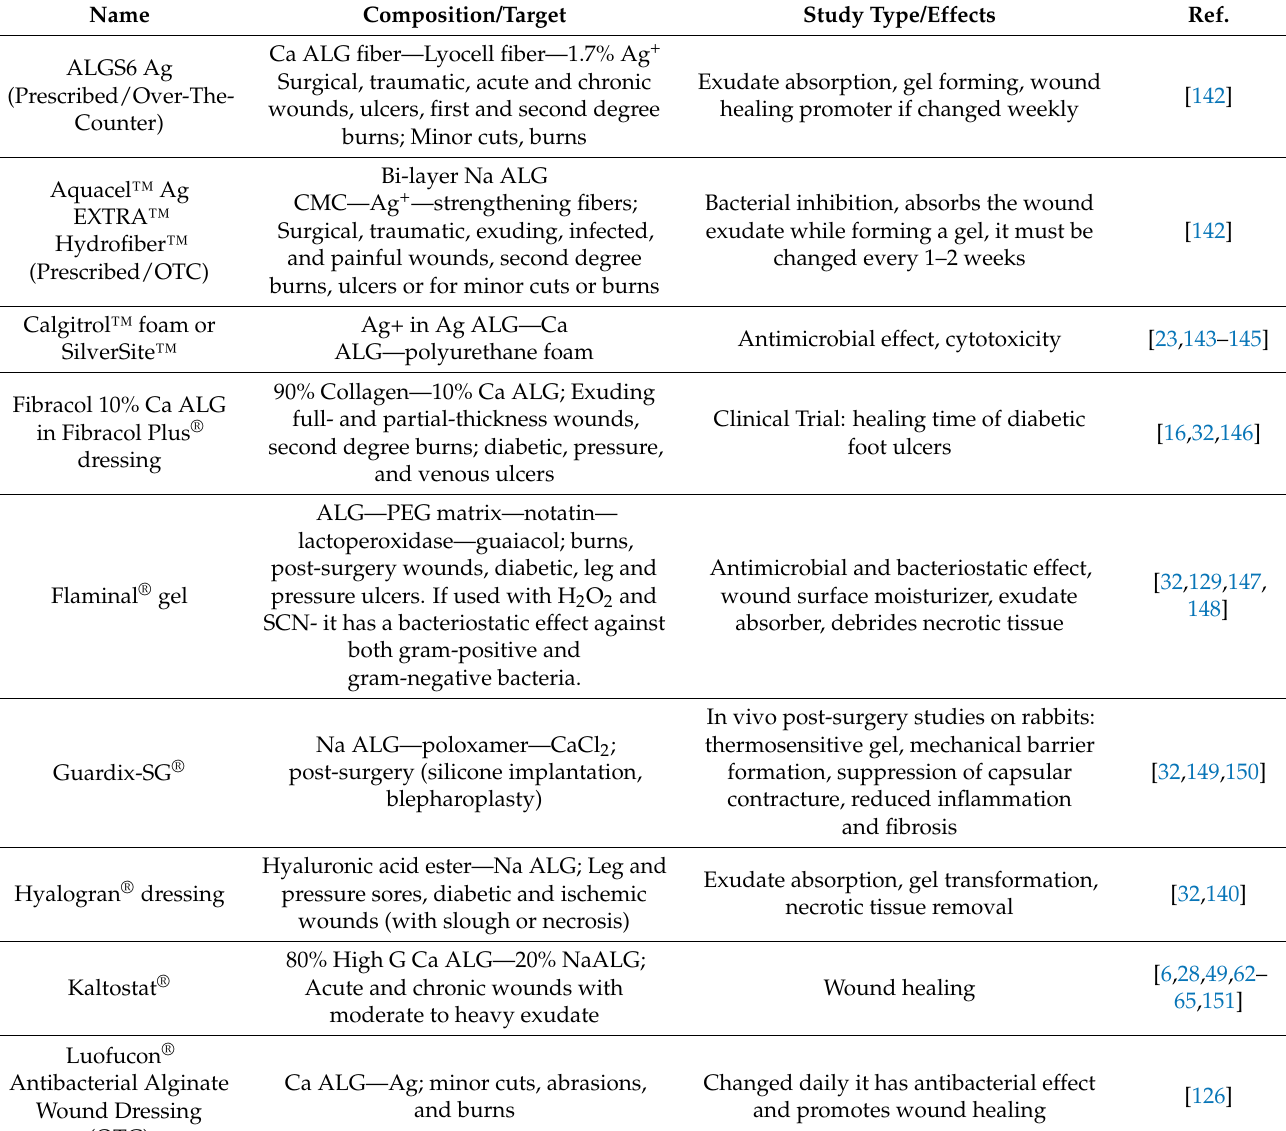
Table 5. Alginate-based commercially available pharmaceutical products used in wound